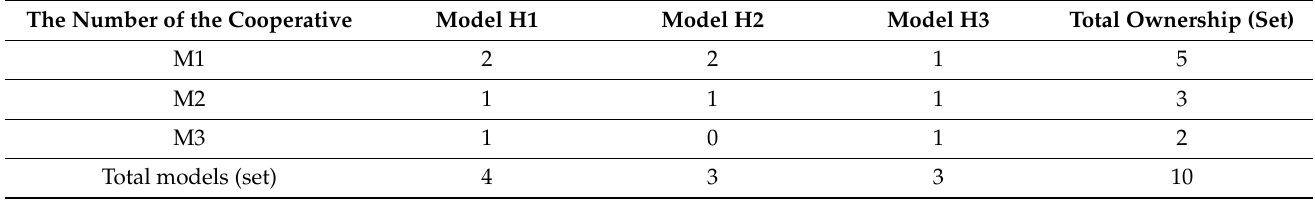
Table 4. The number and models of agricultural machinery owned by each agricultural machin- ery